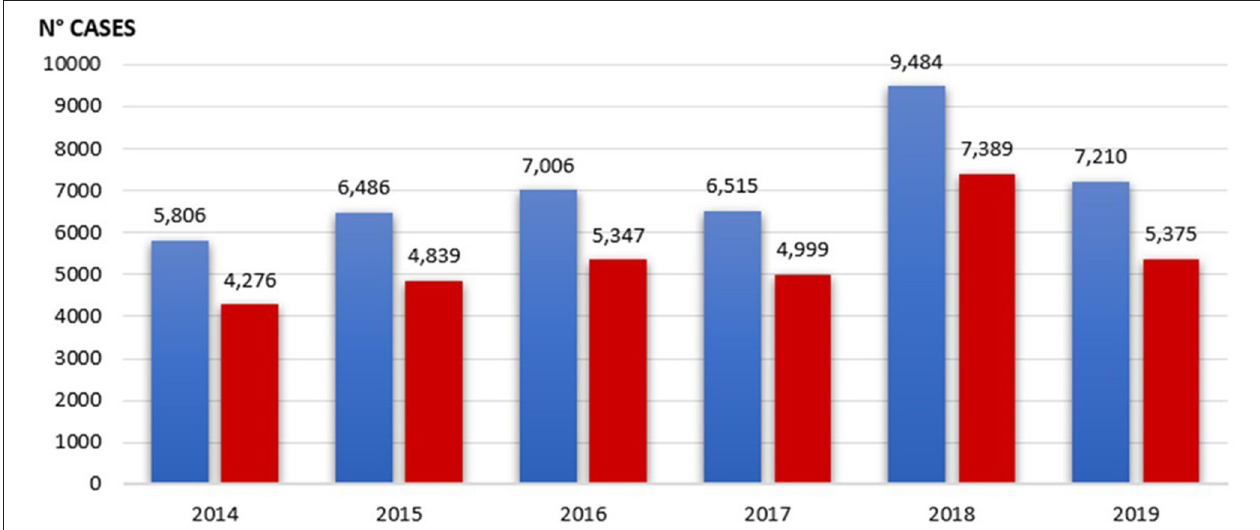
FIGURE 1 | Blue columns represent total visits per year; red columns represent inappropriate visits per year.